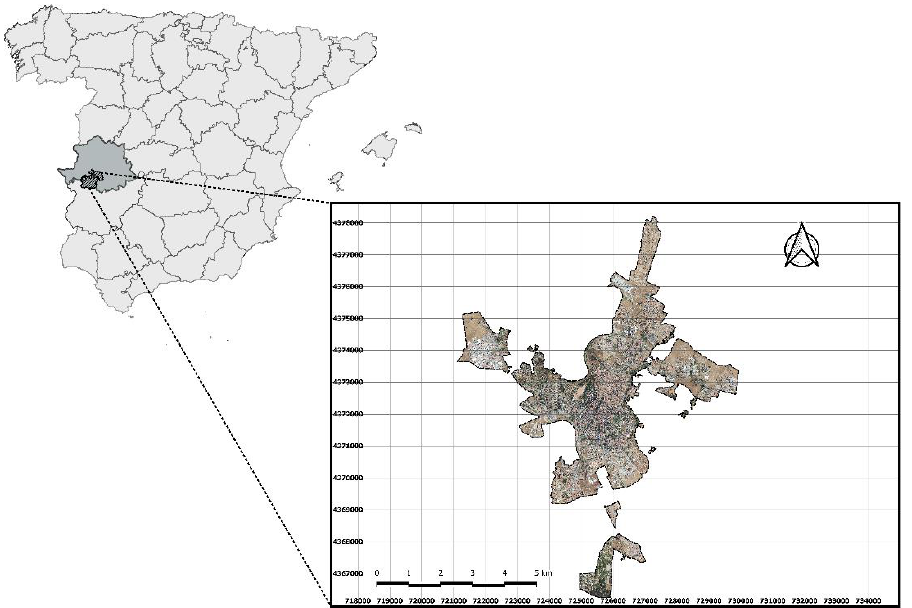
Figure 1. Location of the study area.